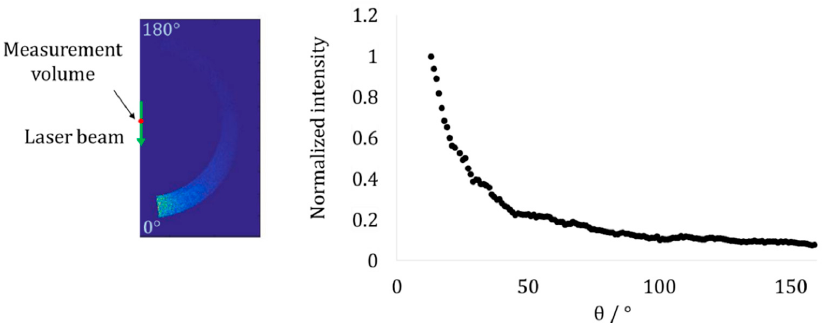
Figure 11. Single-shot calibrated image of half (0–180°) of the ring-shaped WALS scattering data ( left ) and the corresponding normalized scattering intensity ( right ).